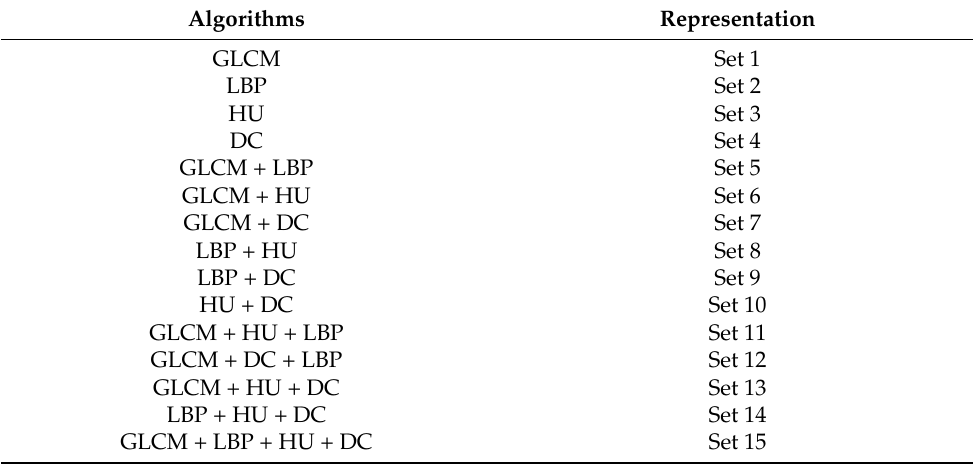
Table 4. Representation of the combinations of feature